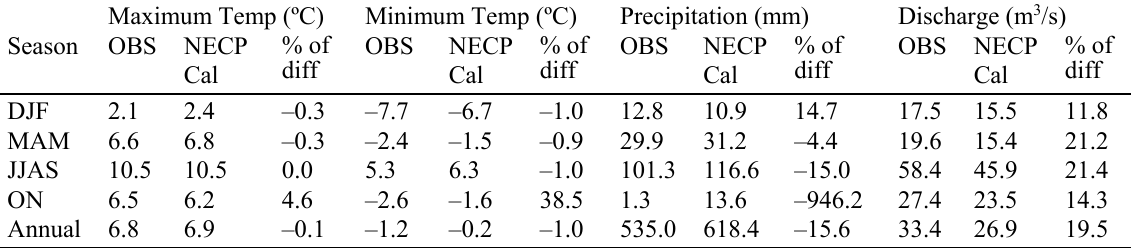
Table 1 Calibration of observed data with CGCM3 of NCEP data.